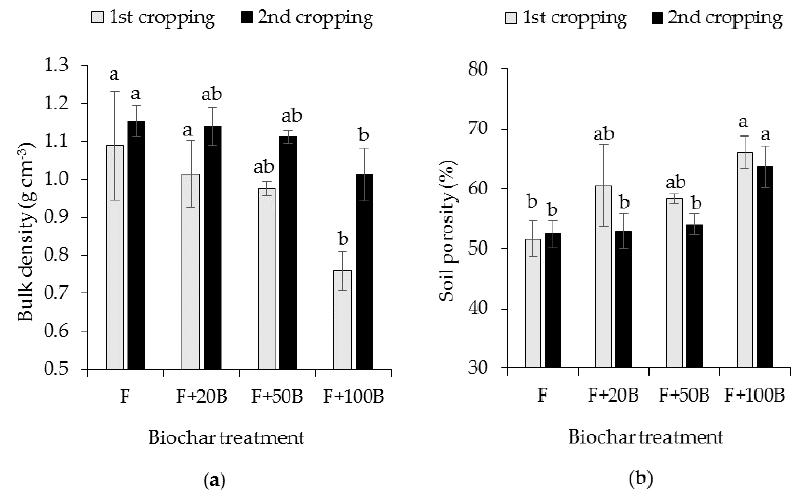
Figure 3. ( a ) The soil bulk density; ( b ) and soil porosity as affected by rice husk biochar treatments. The bars represent the standard deviation of triplicates. Different letters indicate significant difference ( p < 0.05) among treatment means.